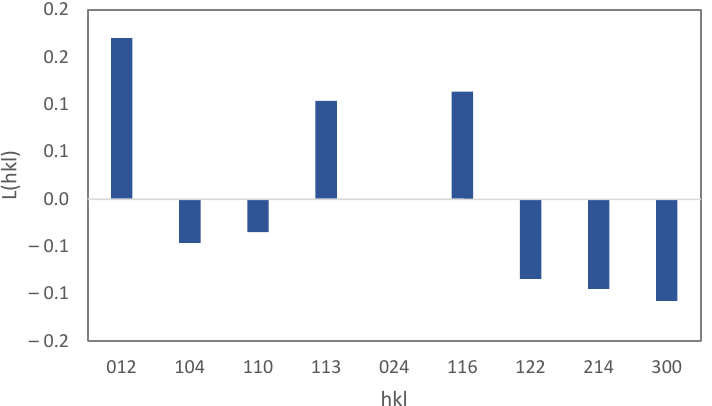
Figure 8. The Lotgering factor, L(hkl), for different crystallographic directions for the thin film sample after calcination.